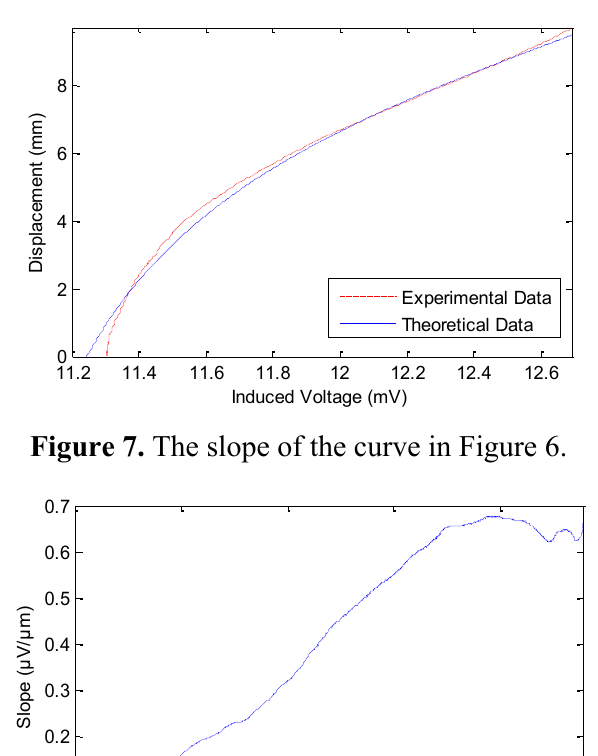
Figure 6. Comparison between the experimental and theoretical results on wide-range measurement.